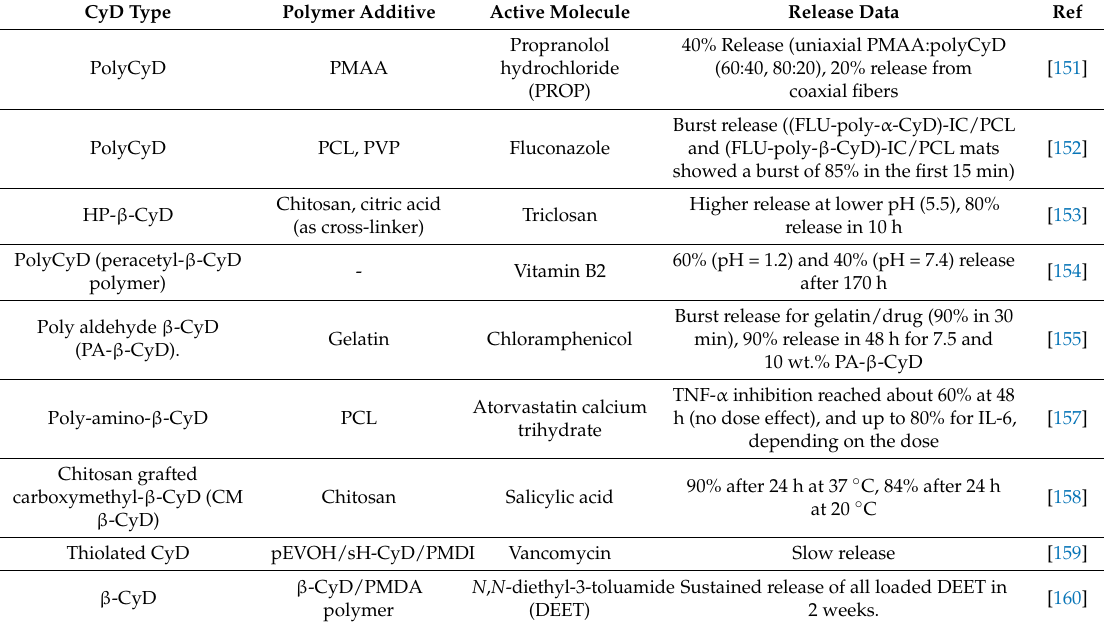
Table 2. Overview of polyCyD/drug electrospun nanofibers used in drug